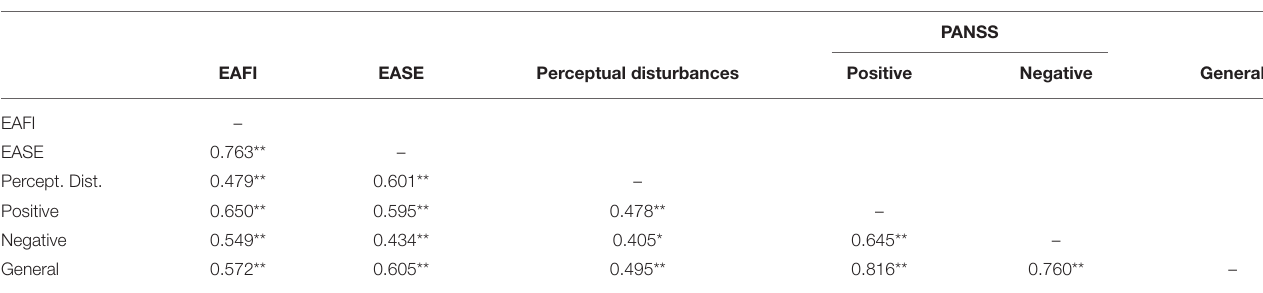
TABLE 2 | Correlations among psychopathological